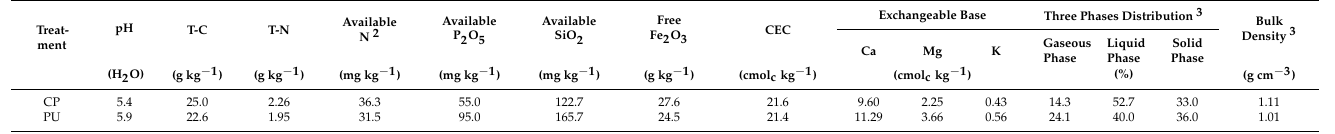
Table 2. Physicochemical properties of the soils in the experimental plots 1